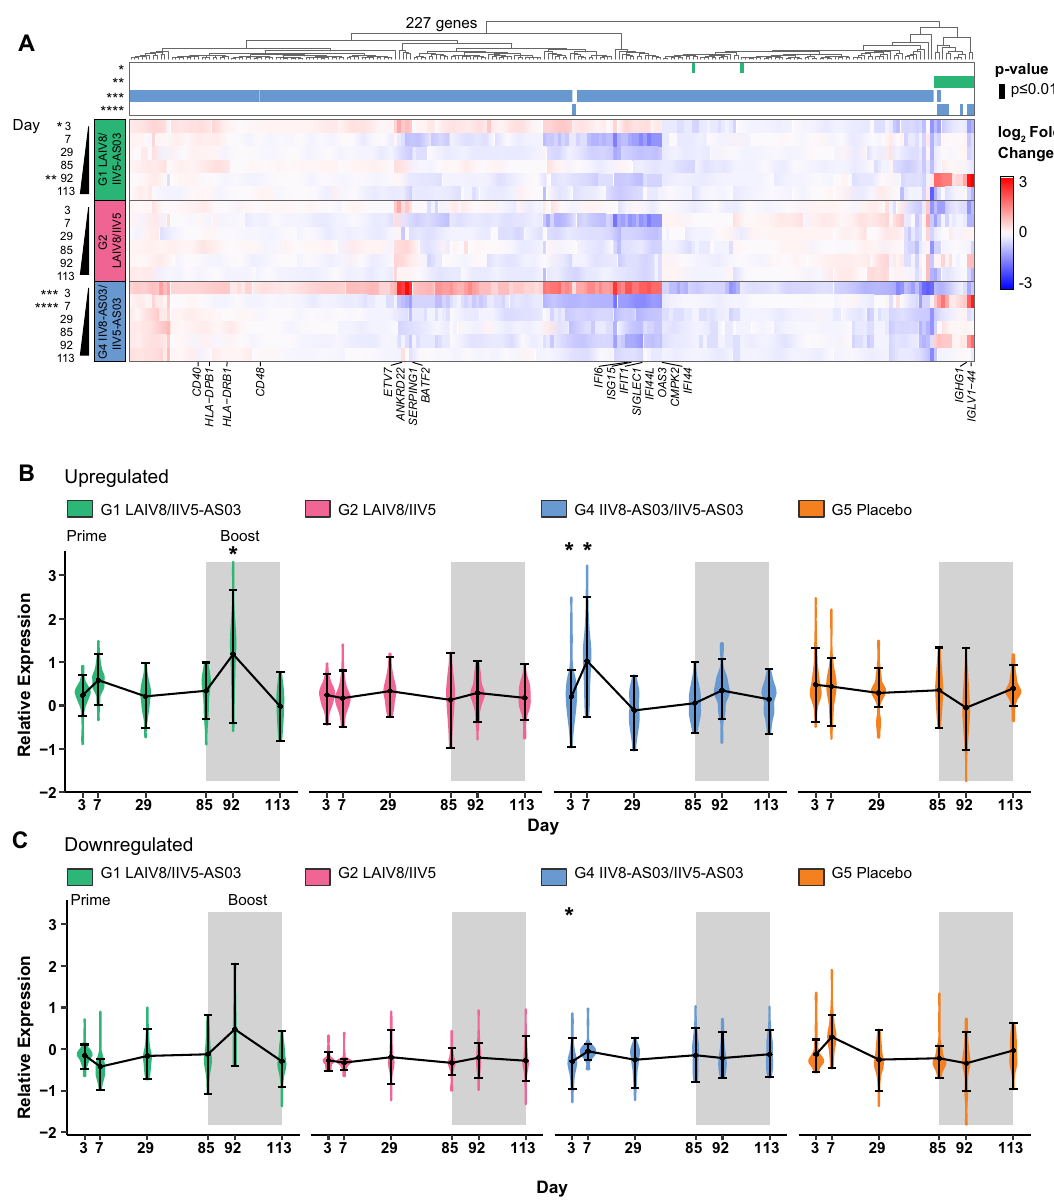
Fig. 2 Global transcriptional pro fi le in the CVIA 057 clinical trial. A Heatmap of differential expressed genes (DEG) in the groups receiving the experimental vaccine compared to placebo (G5: PBS/PBS): group 1 (G1: LAIV8-IIV5/AS03), group 2 (G2: LAIV8-IIV5) and group 4 (G4: IIV8/ AS03-IIV5/AS03). Average log 2 fold changes (FC) DEG in each group against placebo are shown at the indicated time points (Bayes adjusted p value ≤ 0.05, corrected for multiple testing using the Benjamini-Hochberg. B , C Temporal expression changes of induced (log 2 FC > 0.25 in at least 50% of the samples) and downregulated genes (log 2 FC < − 0.25) related to in fl ammation pathways GO:0006954 (in fl ammatory responses), GO:0009615 (response to virus), GO:0034097 (response to cytokines), and GO:0045087 (innate immune response) relative to baseline (day 1) for each of the vaccination groups. Asterisk indicates time points with Bayes adjusted p value ≤ 0.05, corrected for multiple testing using the Benjamini-Hochberg (BH) method. The error bars and whiskers indicate mean ± standard error cells (PBMCs) pro fi led by bimodal protein-RNA measurements with methods. Similarly, no signi fi cant changes of the transcriptional Cellular Indexing of Transcriptomes and Epitopes by Sequencing pro fi le were detected on day 85, before the booster dose, or on (CITE-Seq) at the single-cell level 16 . These cell type-speci fi c gene day 93 (post-boost), consistent with a minimal increase of anti- stalk antibodies in this group (Fig. 1C). expression signatures consisted of 58 cell types and subtypes, The immune response is a complex biological process that including subsets of the T, B, and myeloid cell compartments. To requires multiple interactions among immune cells with hetero- simplify cell type groups, subclusters were collapsed into 37 major genous differentiation states and signaling pathways. We next cell types. We applied a false discovery rate (FDR) < 0.05 (adjusted decided to interrogate the changes in function and cell-type p value, Fisher ’ s exact test) to deconvolute the bulk DEG data and composition of the cells circulating in blood after vaccination with determine cell type-speci fi c speci fi c signatures enriched or the cHA in fl uenza vaccine. For this we used transcriptional depleted in the peripheral blood of G4 after priming with IIV8/ signatures obtained from healthy peripheral blood mononuclear AS03 on day 3 and 7 (Fig. 4A). Fold-change gene signatures